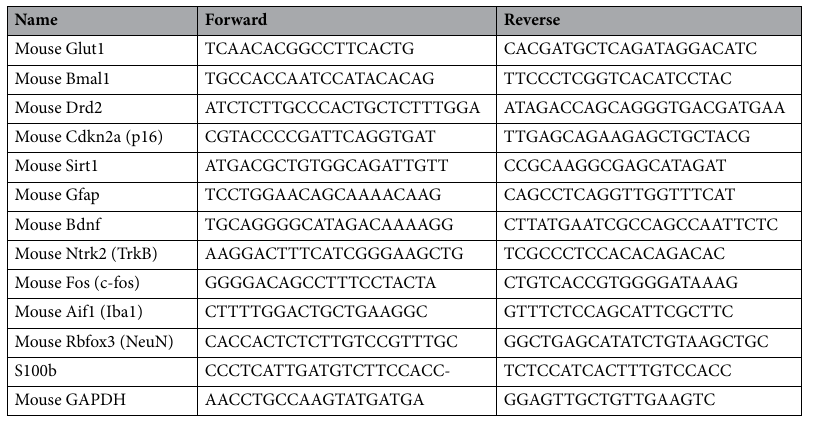
Table 1. Sequences of primers used for real-time